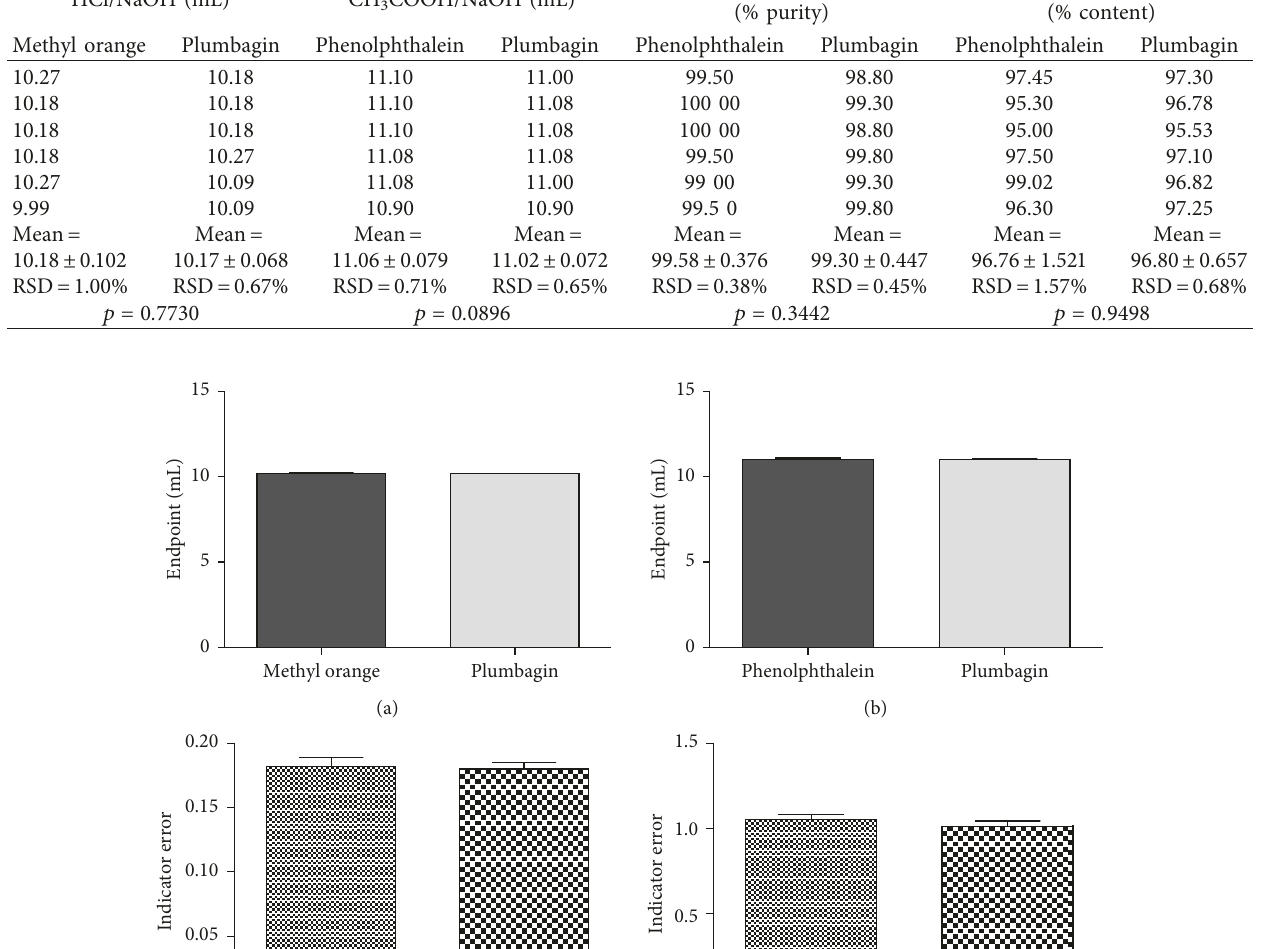
Table 1: Comparison of results obtained using standard indicators and plumbagin. HCl/NaOH (mL) CH 3 COOH/NaOH (mL)